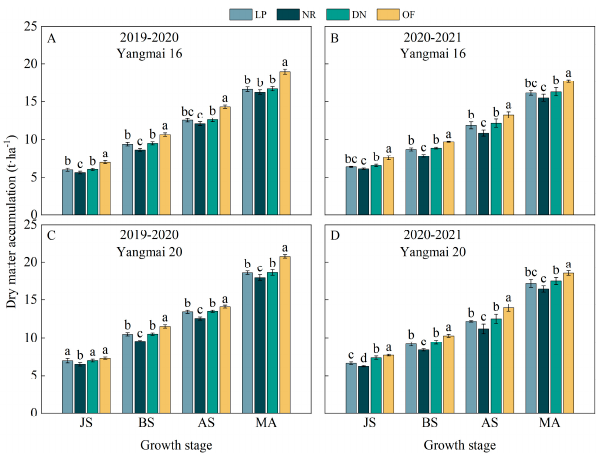
Figure 4. Effect of integrated cultivation practices on dry matter accumulation of two wheat cultivars Yangmai 16 ( A , B ) and Yangmai 20 ( C , D ). LP, NR, DN, and OF indicate local practices, nitrogen reduction, planting density reduction and nitrogen reduction, and organic fertilizer, respectively. JS, BS, AS, and MA indicate the jointing stage, booting stage, anthesis stage, and maturity, respectively. Vertical bar represents the ± standard error of the mean. Different lowercase letters indicate the same period; the difference between different treatments was significant at the 0.05